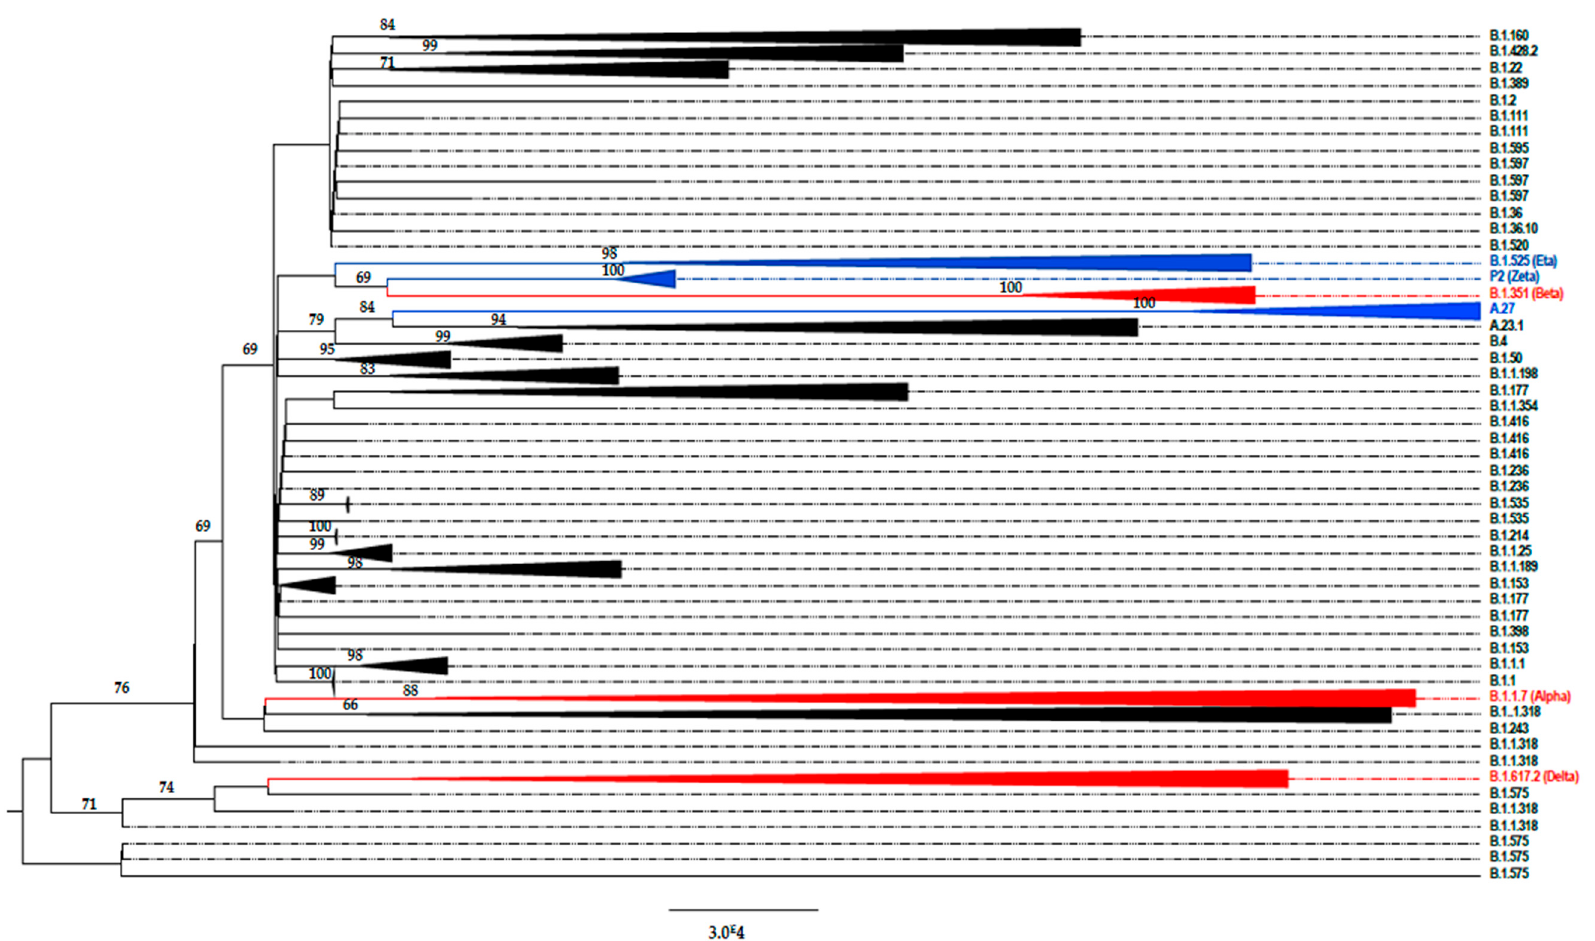
Figure 2. Phylogenetic tree built using IQ-tree and visualized by Figtree based on n = 601 severe acute respiratory syndrome coronavirus 2 (SARS-CoV-2) whole genomes detected in Tunisia between March 2020 and July 2021. The triangles in red correspond to variant of concern (VOC) sequences, variant of interest (VOI) sequences are shown in blue, and other lineages that circulated in Tunisia during the study period are represented in gray. The numbers on branches represent the bootstrap support values.